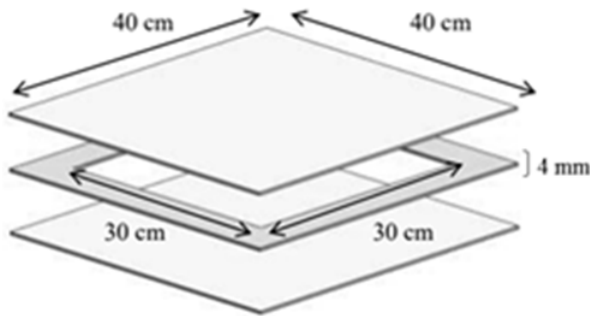
Figure 2. Moulding dimensions.